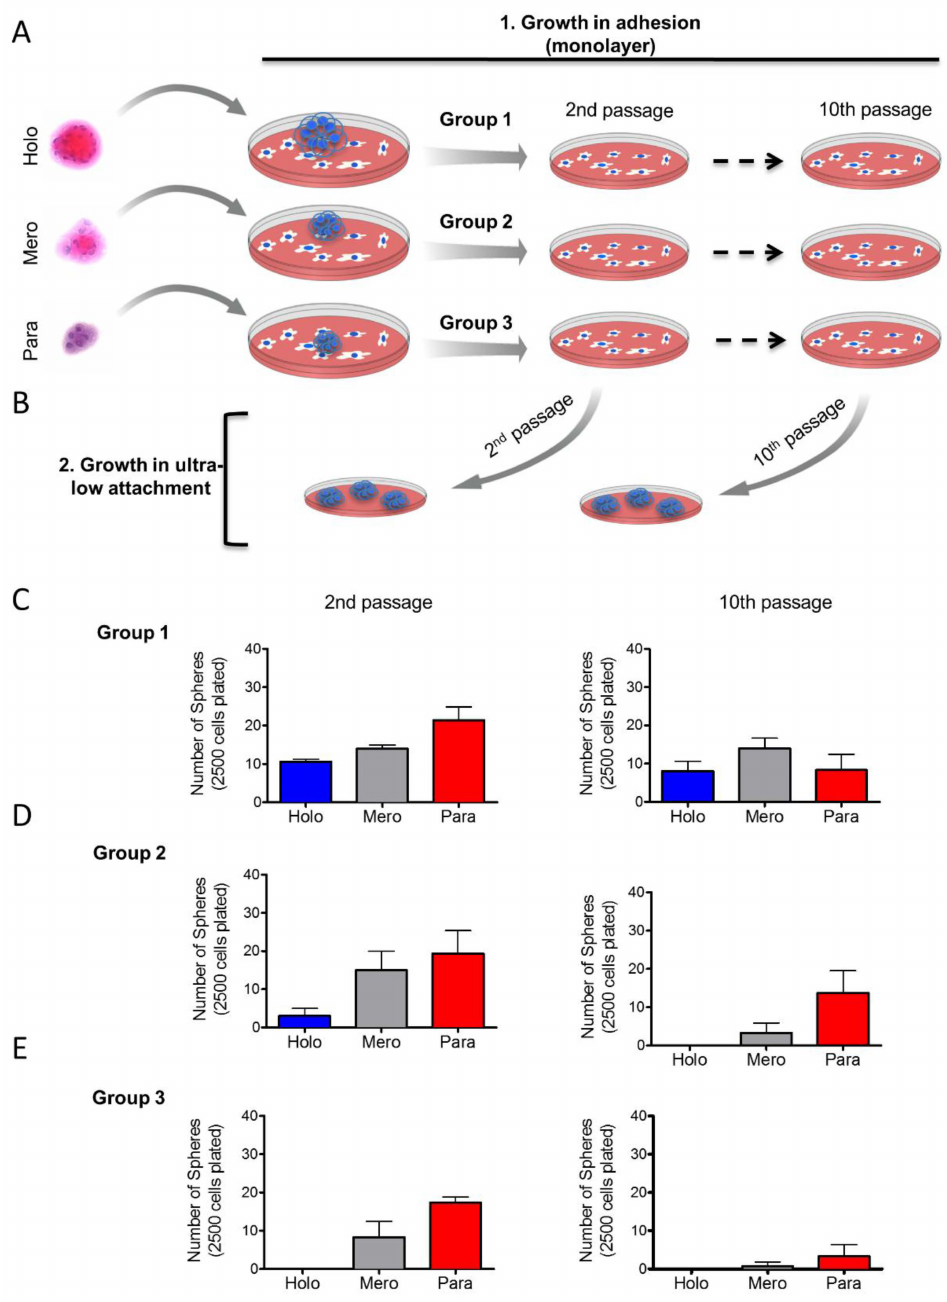
Figure 4. Long-term maintenance of CSC clonogenic potential. ( A ) Schematic representation of long-term culture of sphere-derived tumor cells under adhesion conditions. Tumor spheres from holospheres, merospheres, or paraspheres were isolated and seeded into culture in monolayer. Tumor cells from each group were maintained in monolayer culture for up to 10 passages; ( B ) Schematic representation of tumor cells derived from groups 1, 2, and 3 isolated from passages 2 and 10 and seeded into ultra-low adhesion culture dishes; ( C ) Tumor cells from group 1 (initially derived from holospheres) regenerate holospheres, merospheres, and paraspheres by passages 2 and 10; ( D ) Tumor cells from group 2 (initially derived from merospheres) only generated holospheres by passage 2 but failed to generate holospheres by passage 10; ( E ) Tumor cells from group 3 (initially derived from paraspheres) do not regenerate